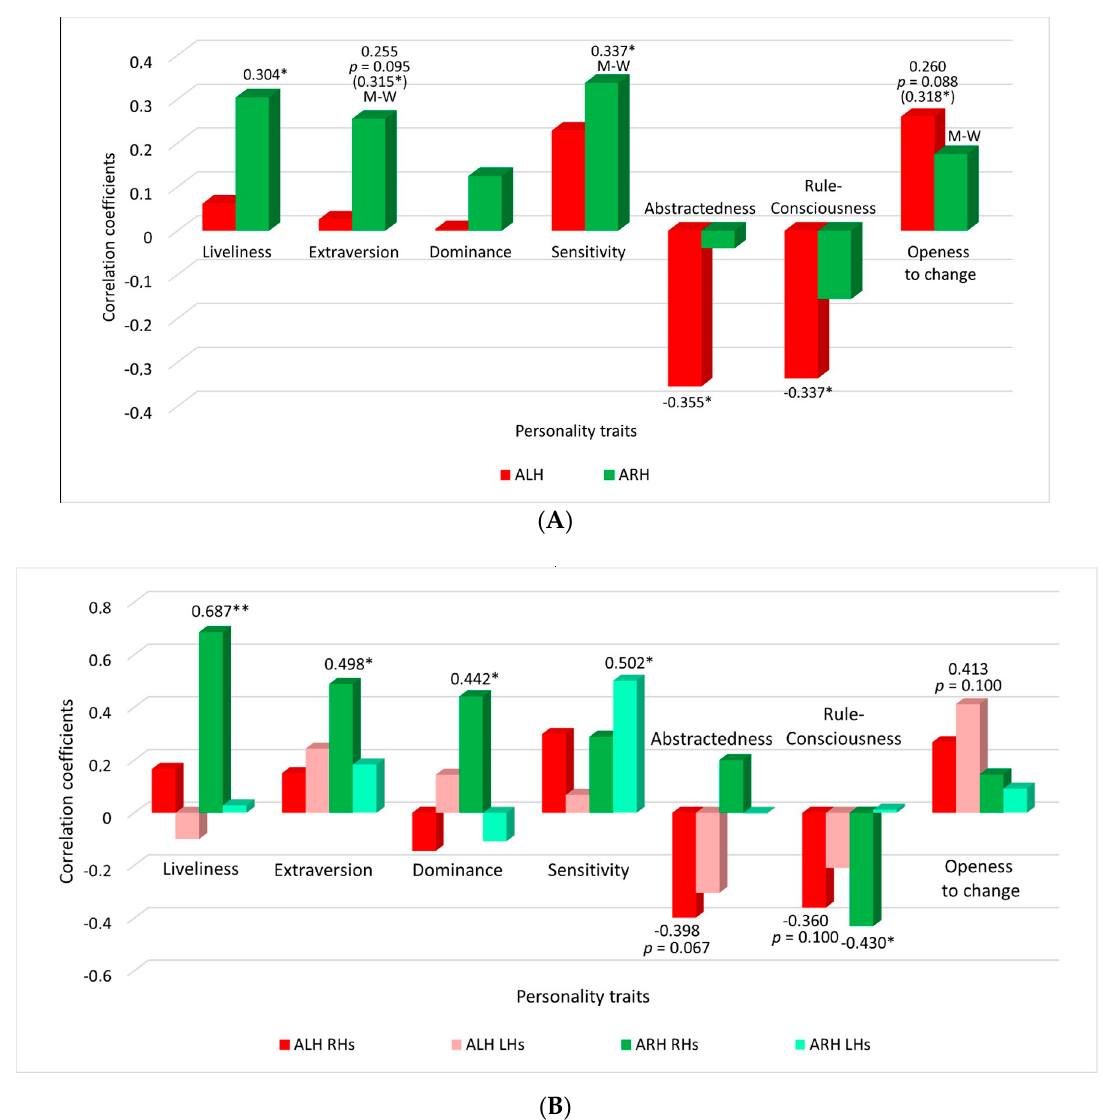
Figure 1. Nonparametric (Spearman’s) correlation coefficients between personality traits and the accuracy of classification of brain signals when imagining movements of the right (ARH, green columns) and left hand (ALH, red columns) in comparison to the rest. ( A )—data of all participants (“pure” right-handers and latent left-handers together), ( B )—data of “pure” right-handers (RHs) and latent left-handers (LHs) separately. Significant correlations are marked with an asterisk (*) ( p < 0.05) or two asterisks (**) (for p < 0.01), p -value is indicated in a case of trend. Significant ( p < 0.05) differences between subgroups with a high and low value of the factor according to Mann–Whitney test are marked with